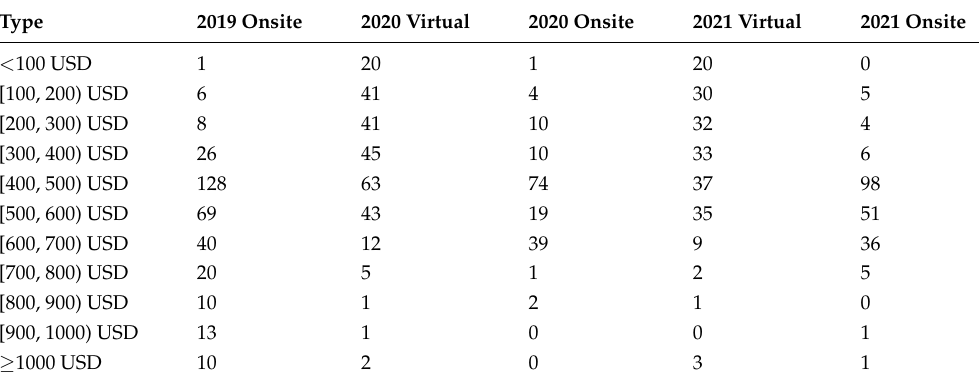
Table 1. Number of conferences with respect to different categories of member fees.